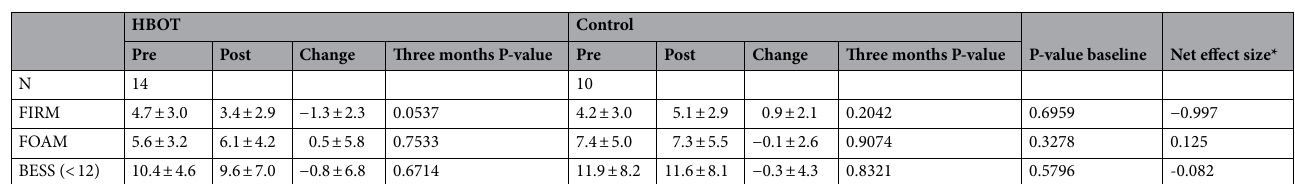
Table 5. Neuro-physical changes. Baseline comparison of p-values test the null hypothesis of equal means of the two groups at baseline using an unpaired t-test; three-month comparison of p-values test the null hypothesis of equal means of each group pre-post intervention (HBOT/sham respectively) using a paired t-test; bold, P < 0.05, net effect size is the subtraction of Cohen’s D effect size of the control group from the HBOT group Cohen’s D effect size.